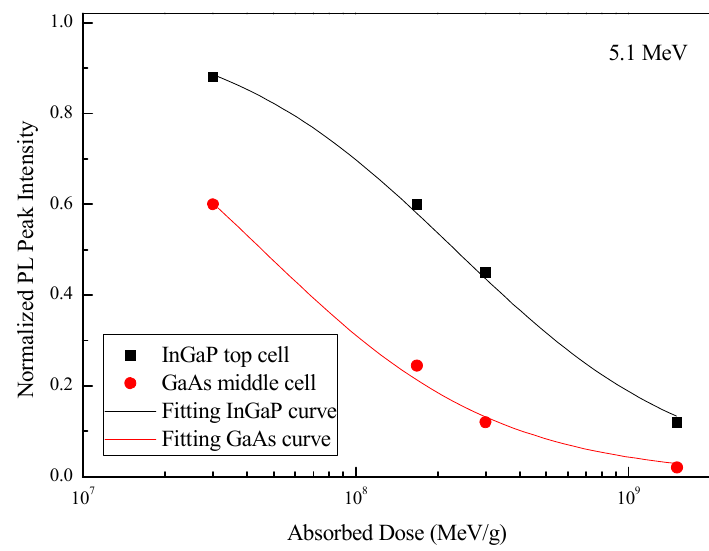
Figure 5. Normalized PL peak intensity of the InGaP top cells and GaAs middle cells as a function of the absorbed dose.